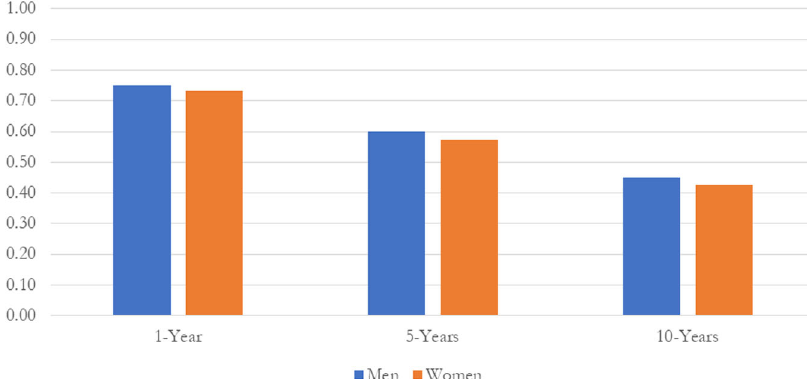
Fig. 2 Mean SLE by gender. Average subjective probability of own survival (weighted) among older men and women, LASI, 2017 – 18.